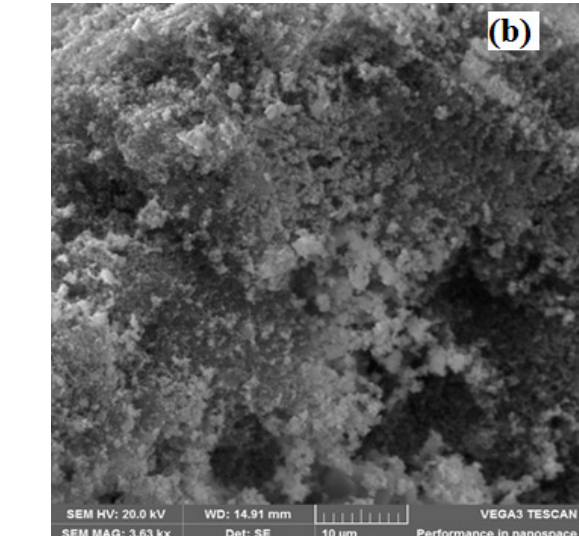
Figure 3. FTIR spectral of SAFA and extracted SNPs.